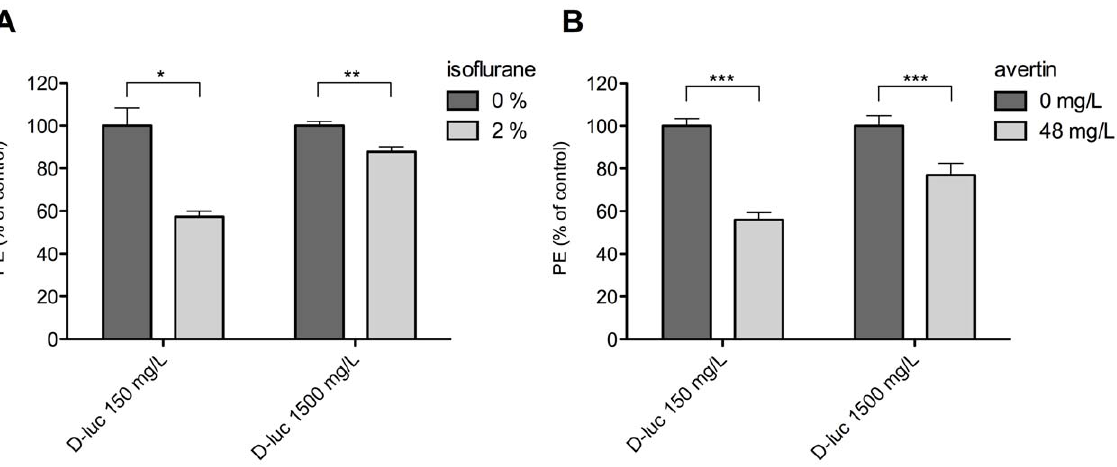
Figure 5. Reversibility of photon emission inhibition by high substrate concentration. Photon emission and its inhibition by isoflurane ( A ) and avertin ( B ) was examined at normal concentration of D-luciferin (D-luc 150 mg/L) and a 10 6 higher concentration (D-luc 1500 mg/L) to assess the reversibility of the inhibition. * p , 0.05, ** p , 0.01, *** p , 0.0001.